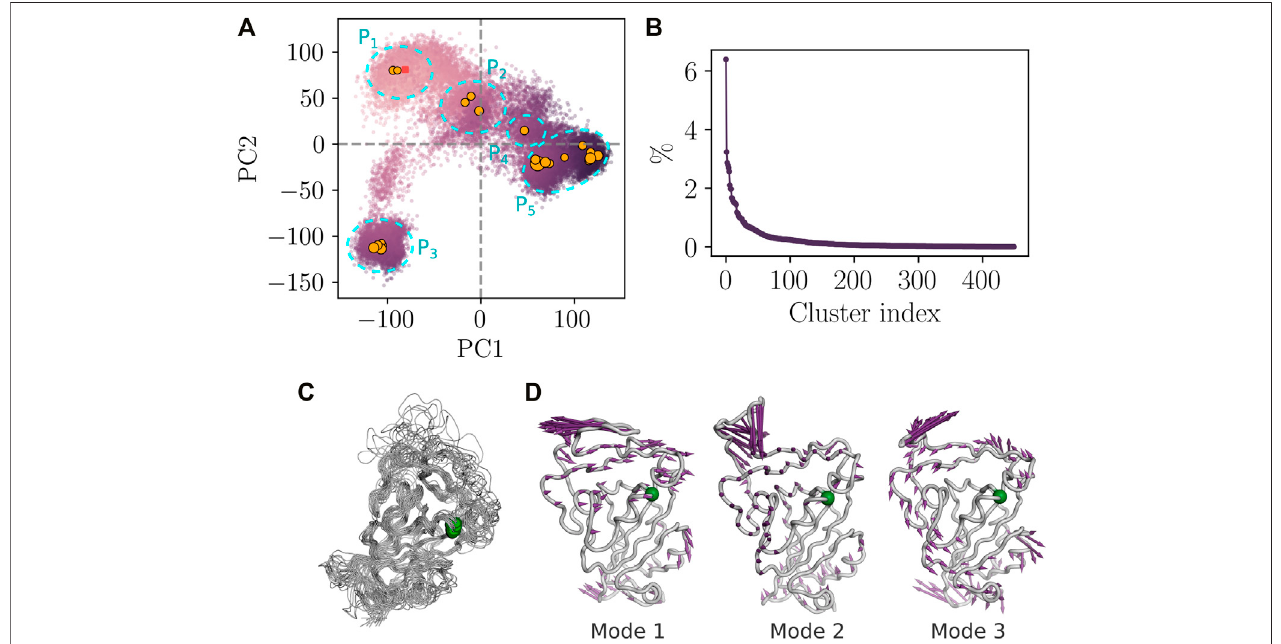
FIGURE 3 | Essential dynamics of RBD from aMD simulation. (A) PCA analysis from the combined replicas. The color of the dots varies as a function of the structural deviation (RMSD) to the crystal structure of RBD. i.e, light purple color indicates lesser deviation and dark purple indicates higher values of RMSD. The square point corresponds to the projection of the crystal structure onto the fi rst and the second subspaces. Orange circles correspond to the centroids of the highly populated clusters and the size of the circles is proportional to the occupancy of the cluster. (B) Occupancy of RBD structural clusters. (C) Structural alignment of the highly populated clusters (occupancy > 1%). Green spheres indicate the position of the RGD motif. (D) Porcupine plot corresponding to projections of C α atoms onto the fi rst three non-rotational and non-translational normal